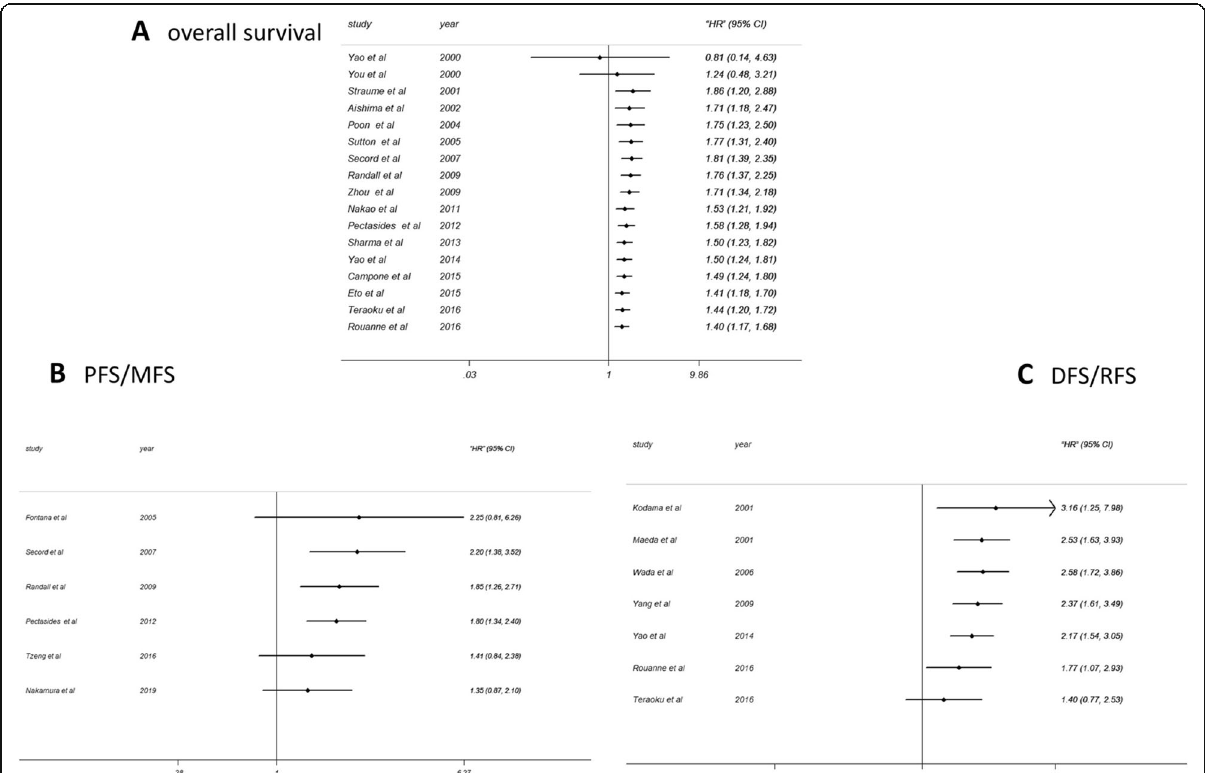
Fig. 5 Cumulative meta-analyses for survival associated with TSP-1 expression. (A) Cumulative meta-analysis of OS; (B) Cumulative meta-analysis of PFS/MFS; (C) Cumulative meta-analysis of DFS/RFS. Abbreviation: OS, overall survival; PFS, progression-free survival; MFS, metastasis-free survival; RFS, recurrence-free survival; DFS, disease-free survival; HR, hazard